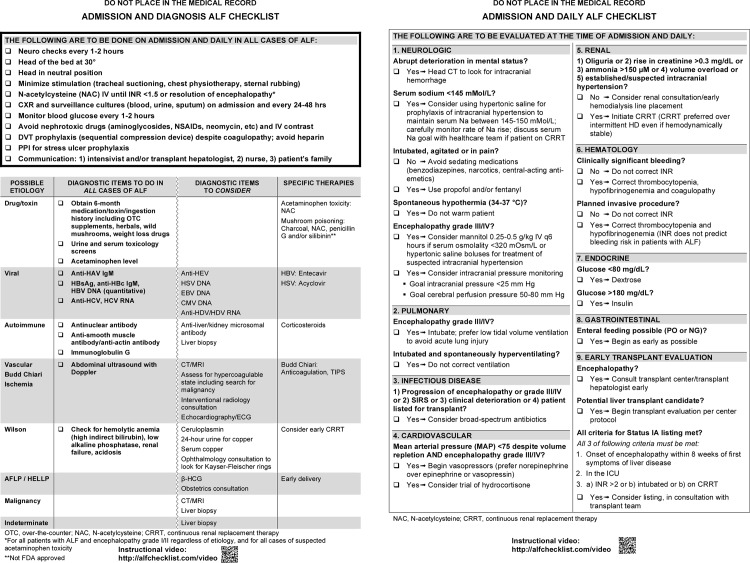
Final checklist.